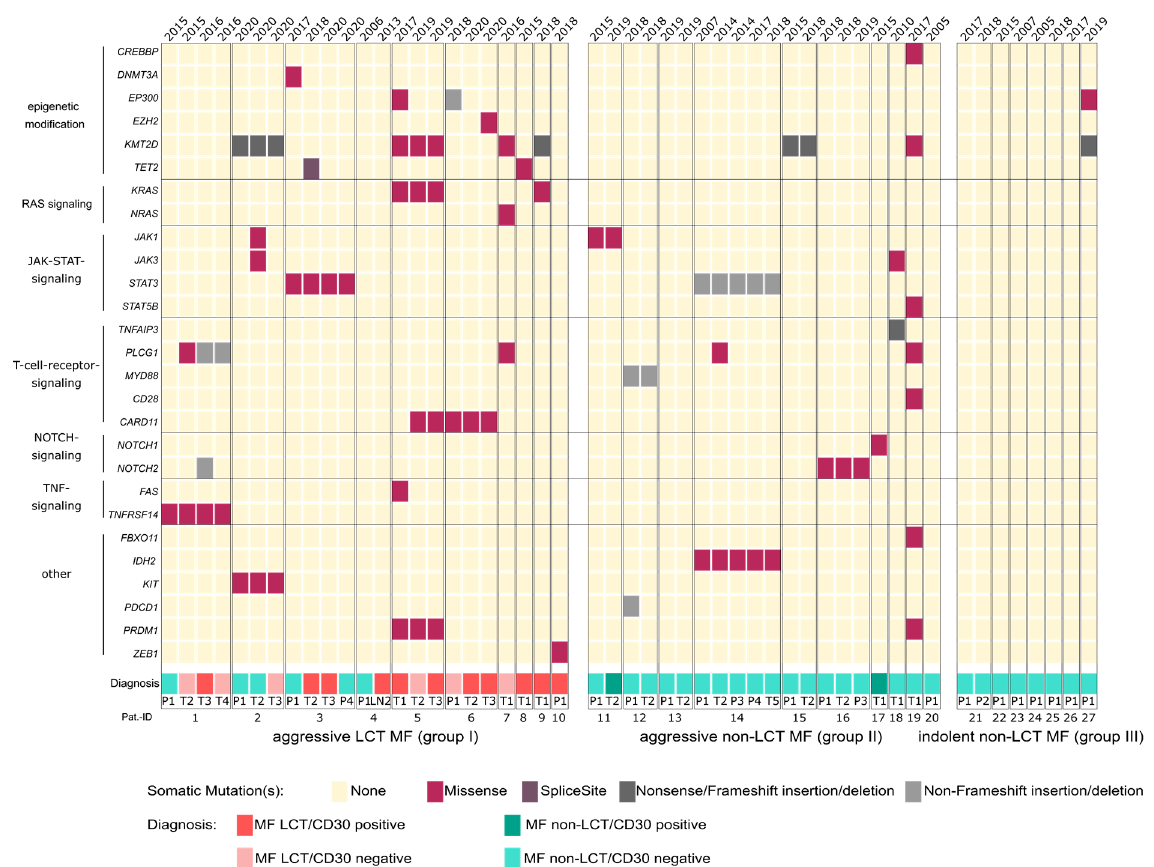
Figure 1. Mutational profile of LCT MF. Sequenced patients are divided into three groups: group I, aggressive LCT-MF (large cell-transformed mycosis fungoides); group II, aggressive non-LCT MF; and group III, indolent non-LCT MF. Groups II and III served as control cohorts. Different intra-individual samples are illustrated chronologically. Sequenced genes and their functions are annotated at the left. Type of mutations and diagnoses are color-coded as indicated. T: tumor stage of MF; P: patch/plaque stage of MF; LN: lymph node.